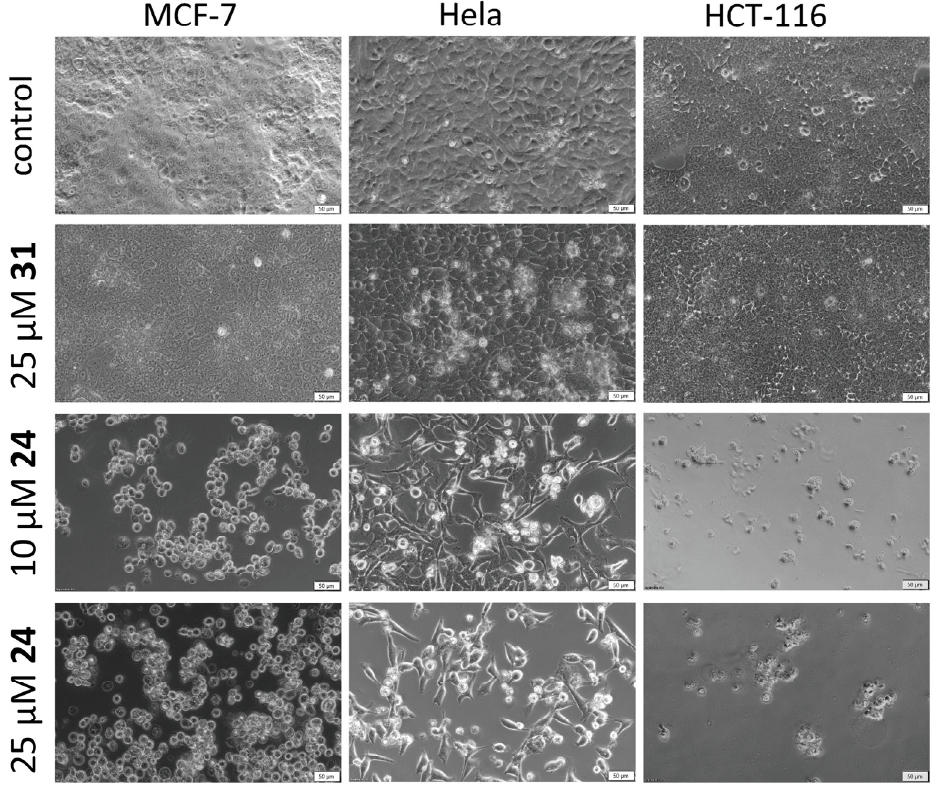
Figure 7. Morphology of MCF-7, HeLa, and HCT-116 treated with 24 or 31 . Light microscopy photographs with 20× objective of cells treated with 24 [10 μ M/25 μ M] or 31 [25 μ M] for 72 h. Scale bar 50 μ m.